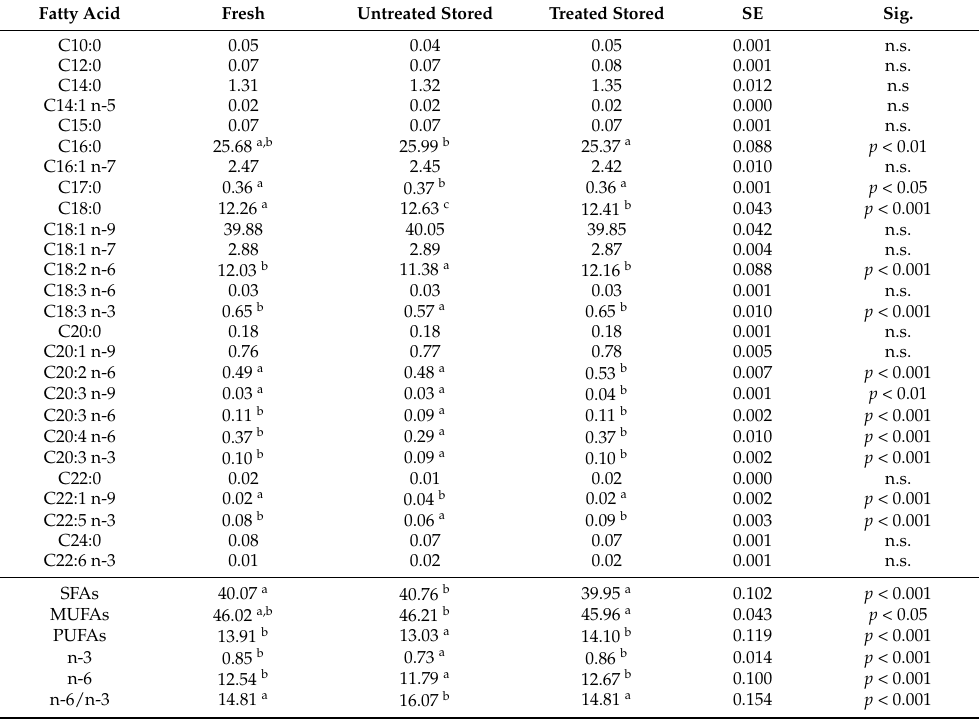
Figure 2. Chromatogram of a sausage sample with abbreviations of the identified fatty acids. Fatty acids were separated in the form of fatty acid methyl esters (FAMEs). Butylated hydroxytoluene (BHT) was added during extraction to avoid the further oxidation of fatty acids during analytical sample preparation (retention time: 15 min). The internal standard was C19:0. The retention time of thymol was 22.6 min. Table 1. The effect of thymol treatment on the fatty acid compositions of the sausage samples, expressed as fatty acid methyl ester %. Stored samples were refrigerated at 6 °C for eight weeks. Fatty Acid